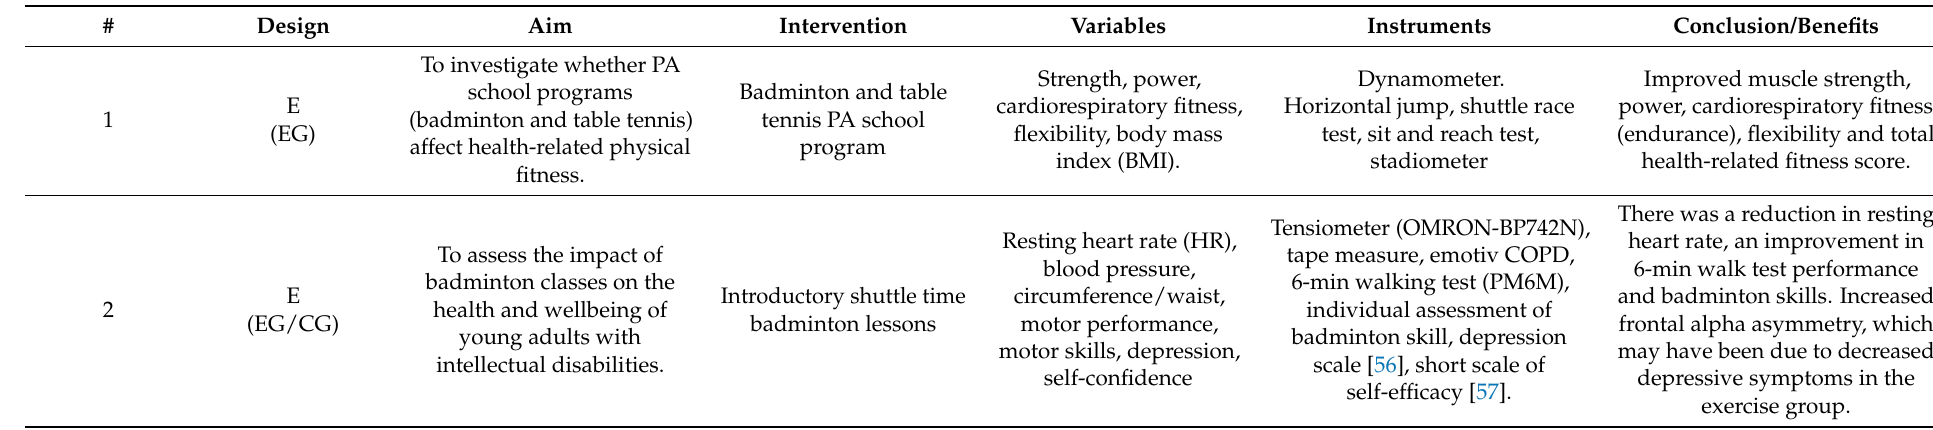
Table 2. Main data collected from analysed